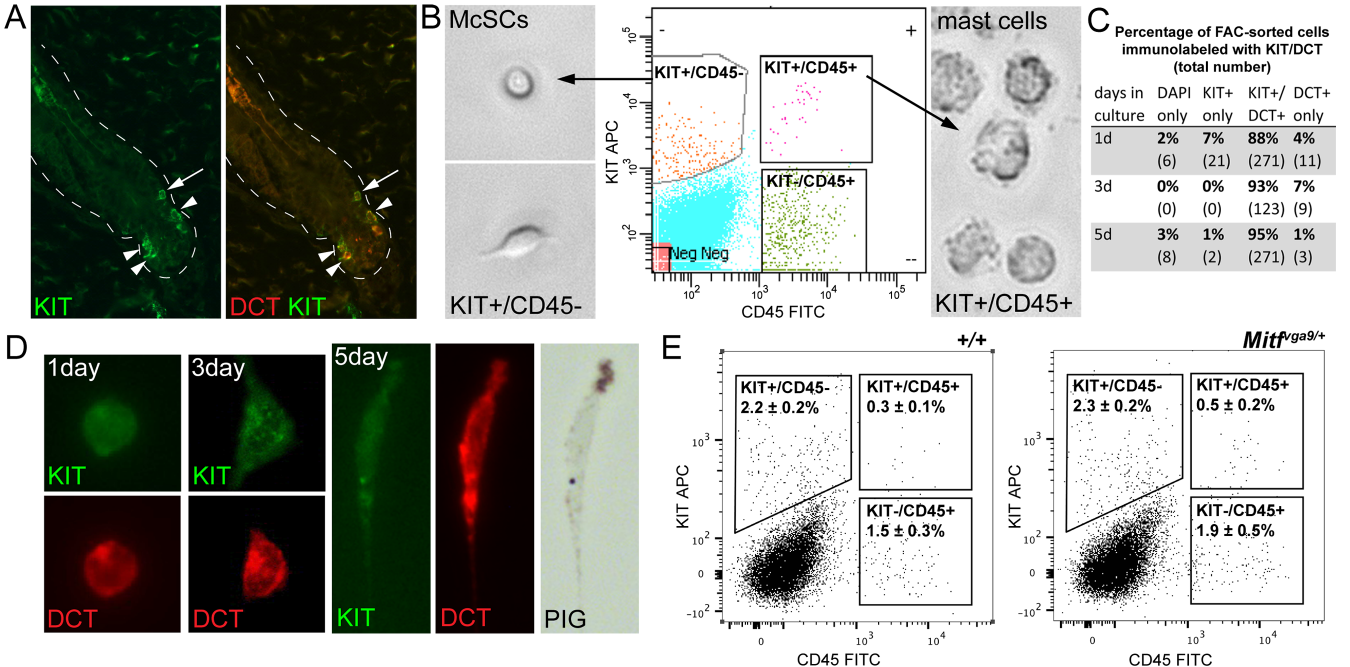
Fig 2. FACS isolation of adult McSCs. (A) Immunolabeling for KIT protein in mouse skin at 8 weeks of age. At this time point, the majority of hairs exist in the telogen hair stage, and McSCs that are positive for both KIT (green) and DCT (red) are observed in the hair bulge (arrow) and secondary hair germ (arrowheads). The dotted white lines outline the hair follicles. (B) FACS of dermal cells from 8-week-old mice produces two KIT+ populations. McSCs are CD45 − and mast cells are CD45+. The FACS gating strategy (center fluorescence plot) used to isolate McSCs successfully separates each of these cell types and is confirmed by visualizing their distinct morphologies; McSCs are small and often bipolar (left phase images), while mast cells are large and rough looking (right phase image). (C) KIT+/CD45 − cells isolated by FACS were placed in culture and assessed for their expression of KIT and DCT by immunolabeling over a 5-day period. Total cells were identified by the nuclear marker DAPI. The table shows the percentage and total number (in parentheses) of cells exhibiting the indicated staining pattern. This FACS protocol produces a relatively pure McSC population, with > 92% of cells being DCT+ 1 day after sorting. (D) FACS-isolated KIT+/CD45 − McSCs remain positive for the melanocyte markers KIT (green) and DCT (red) and exhibit melanocyte-like traits while in tissue culture. These cells progress from being round at 1 day, to slightly spread at 3 days, to dendritic and pigmented over 5 days. (E) Evaluation of the indicated gates (boxes) on FACS fluorescence plots confirms that there is no significant difference by t test when comparing the percentage of each cell population between wild-type (left plot) and Mitf mi-vga9/+ (right plot) dermal cell suspensions (KIT+/CD45 − , p = 0.85; KIT+/CD45+, p = 0.14; KIT − /CD45+, p = 0.28). Percentages are represented as the mean ± standard deviation, with n = 3 sorts per genotype. The raw data used to generate these graphs are available in S1 Data . APC, allophycocyanin; CD45, cluster of differentiation 45; DCT, dopachrome tautomerase; FACS, fluorescence-activated cell sorting; FITC, fluorescein; McSC, melanocyte stem cell; Mitf , melanogenesis associated transcription factor; Neg, negative; PIG, pigment.